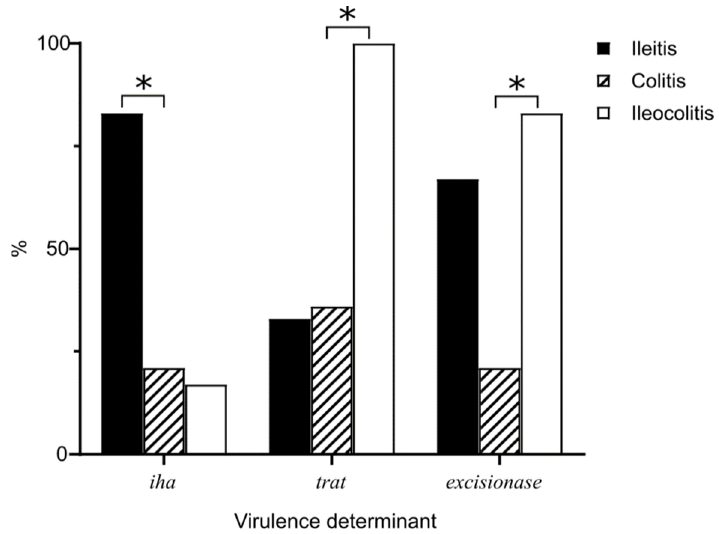
Figure 2. Frequency of occurrence of significantly different virulence genes in E. coli strains from patients with Crohn’s disease, depending on disease location (* p < 0.05, Fisher’s exact test). Bacteriocin-producing systems benefit bacteria through their growth in a competitive environment as well. Screening of sequenced E. coli genomes revealed 28 strains (16 healthy and 12 CD-derived) containing genes for colicin and microcin production (Supplementary Materials Table S4). Microcin production systems, known for their promotion of gut colonization [60,61], were found equally in healthy and CD-derived strains. In iso-